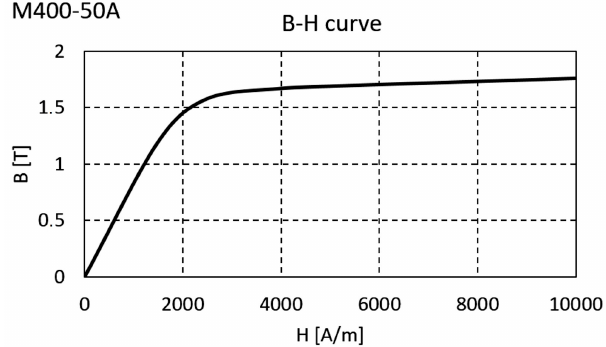
Figure 9. The B – H curve of M400-50A lamination.